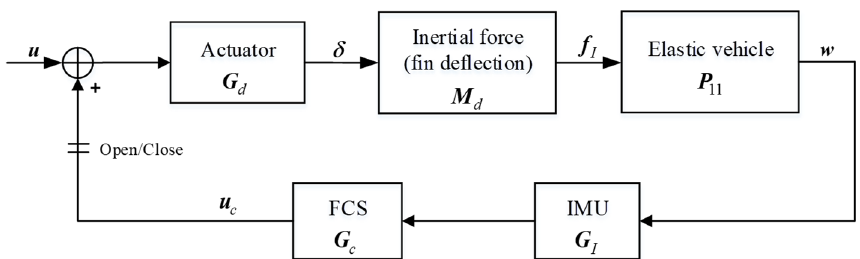
Figure 2. Block diagram of the SCT system.